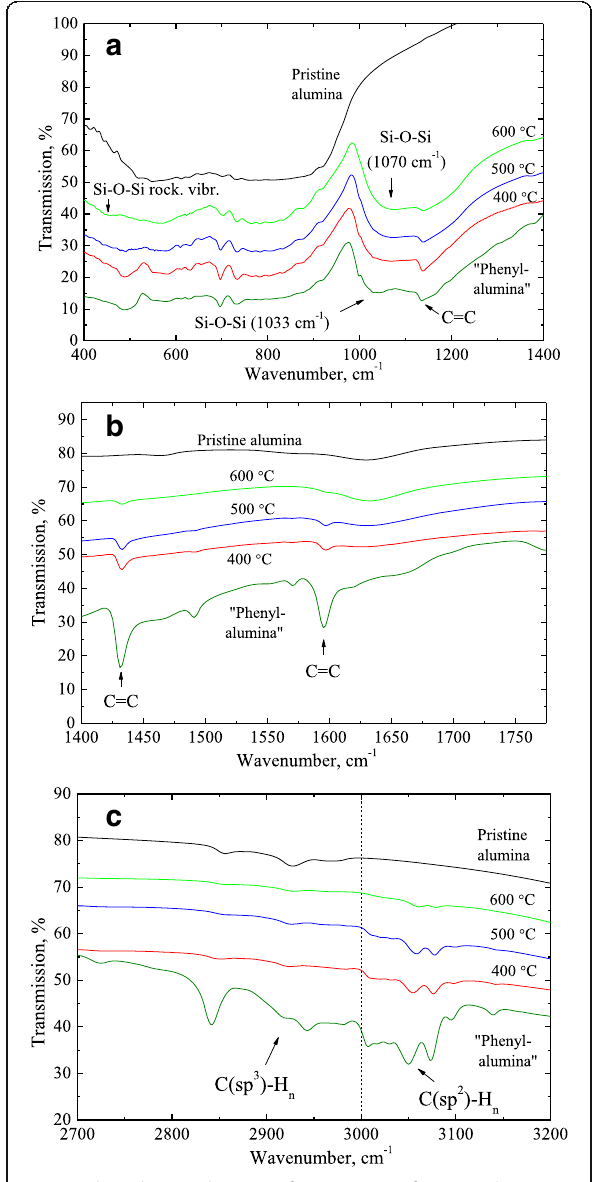
Fig. 2 Selected spectral ranges of FTIR spectra of pristine alumina (spectrum 1), and phenyl-alumina before and after annealing at 400, 500, and 600 °C in the spectral ranges 400 – 1400 cm − 1 ( a ), 1400 – 1775 cm − 1 ( b ), and 2700 – 3200 cm − 1 ( c ). Spectra are offset along the ordinate axis for